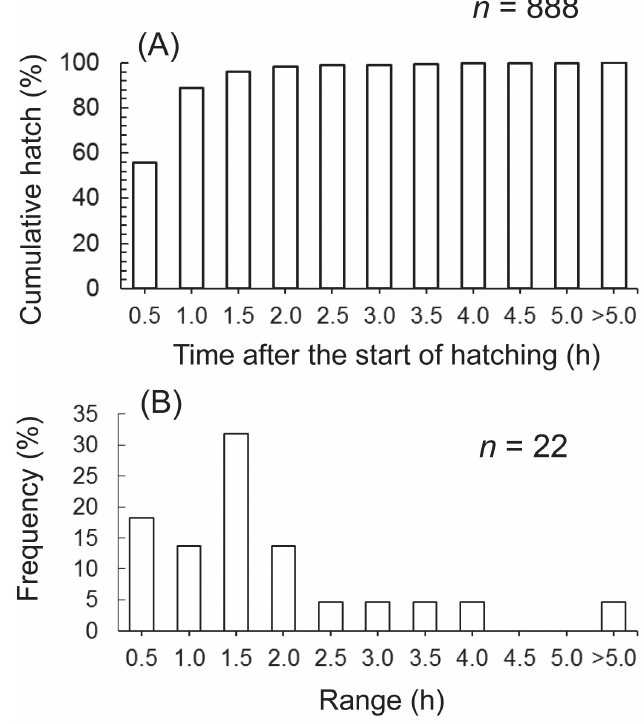
Fig. 1. Hatching patterns of L. migratoria eggs kept in the pods at 30°C under continuous illumination. Cumulative percentages of hatched eggs from 22 egg pods plotted against the time after the start of hatch- ing for each pod ( A ). The frequency distribution of ranges from the beginning to end of hatching period from the respective pods ( B ).